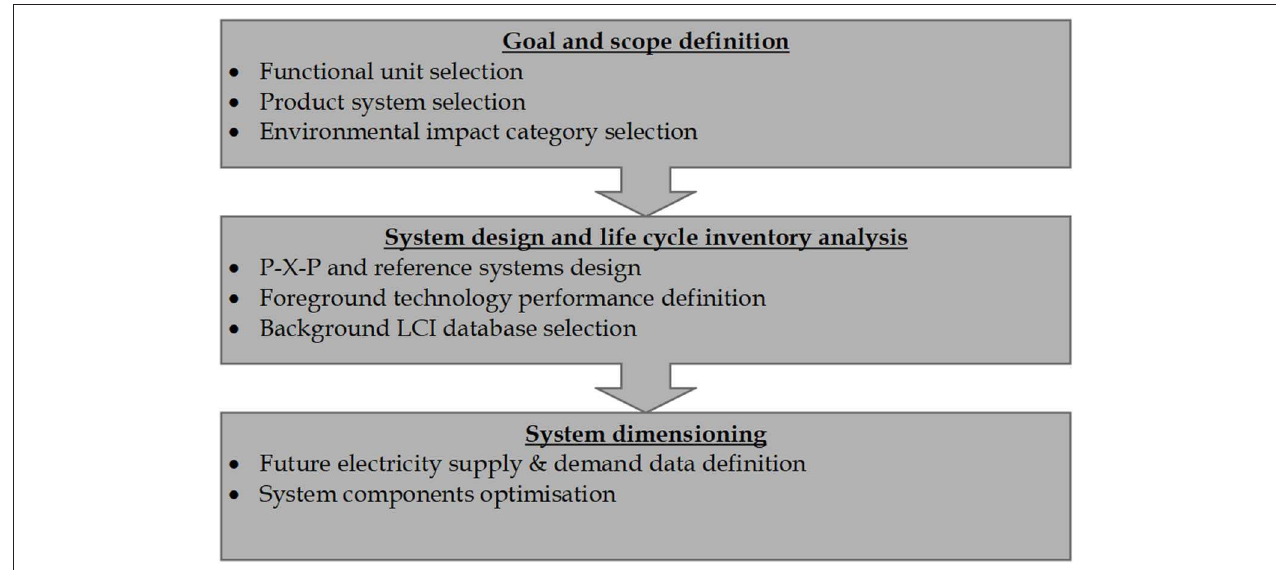
FIGURE 1 | Schematic of the research approach used in this